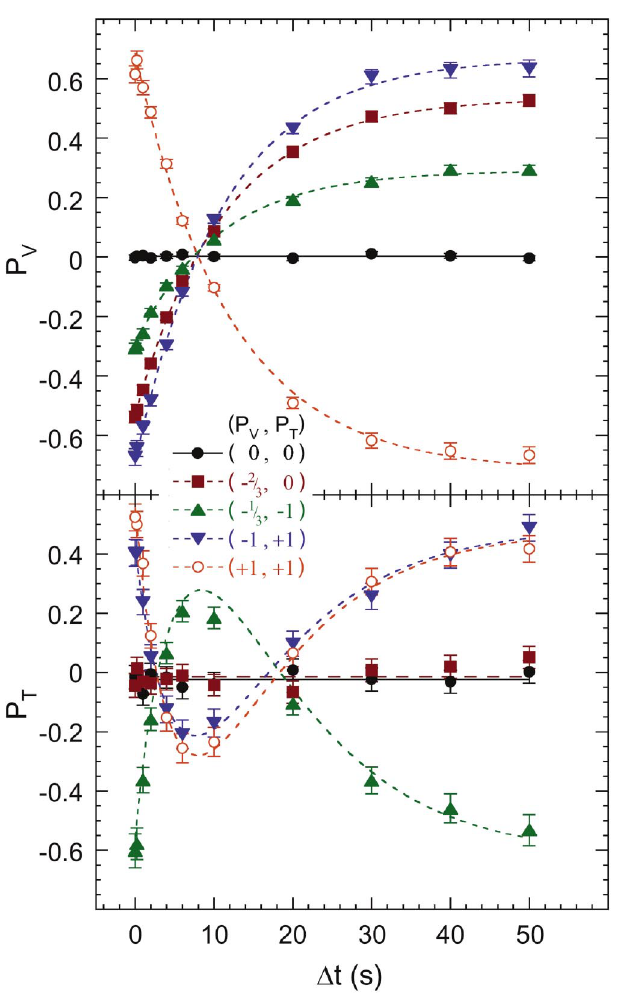
FIG. 4. (Color) The measured vector and tensor deuteron polar- izations at 1850 MeV =c are plotted against the rf dipole ramp time (cid:18) t . The rf dipole’s frequency half-range (cid:18) f= 2 was 100 Hz , dl was 0 : 54 T mm . The top and bottom curves are and its R B rms fits using Eqs. (9) and (11), respectively.